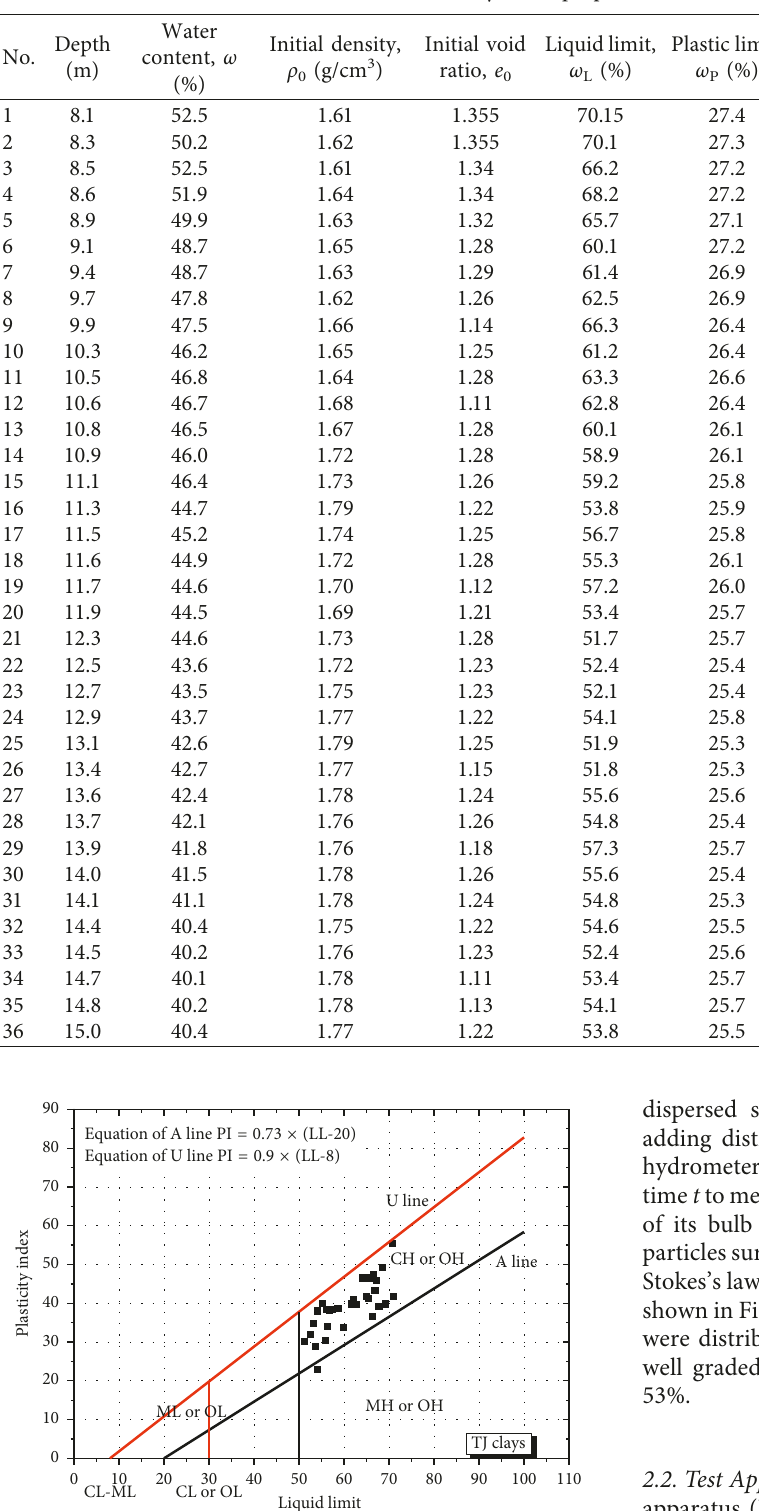
Table 1: Primary index properties of the tested Tianjin clays.